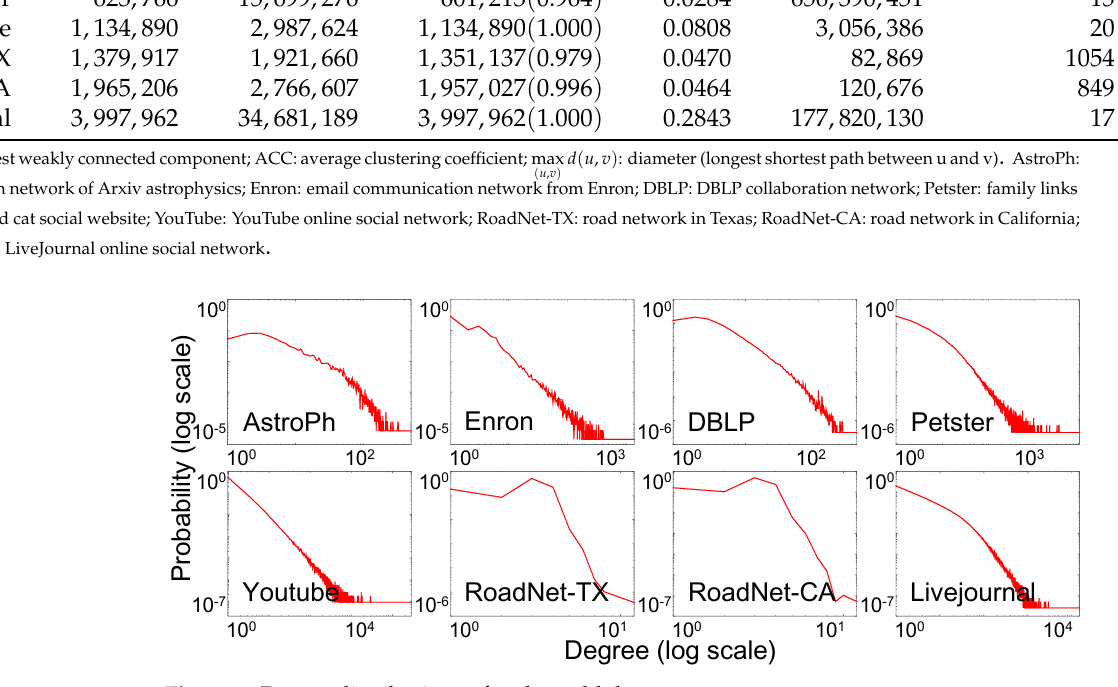
Figure 3. Degree distributions of real–world